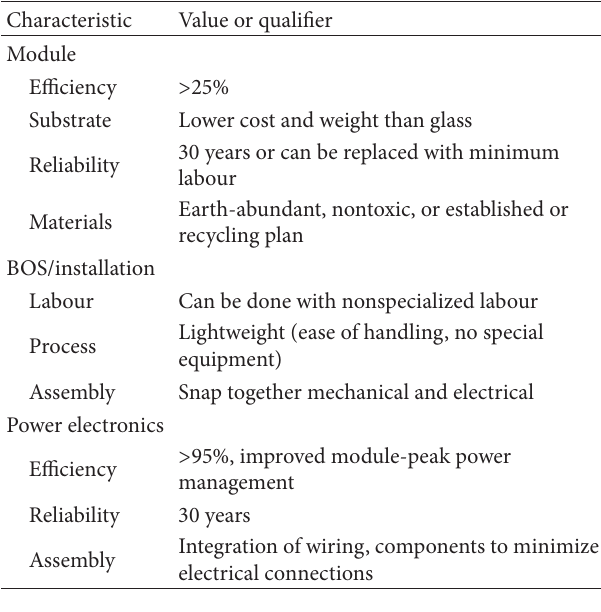
Table 3: Pathways of cost reduction potential for photovoltaic systems [27].